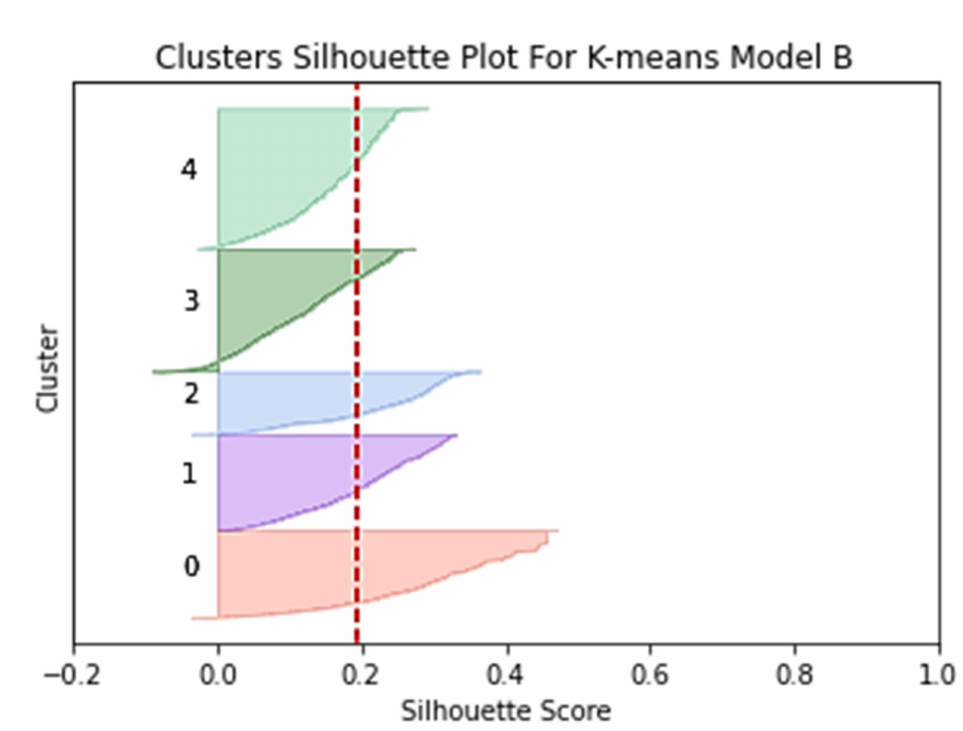
Figure 3. Clusters silhouette plot for k-means Model B (KMoB).